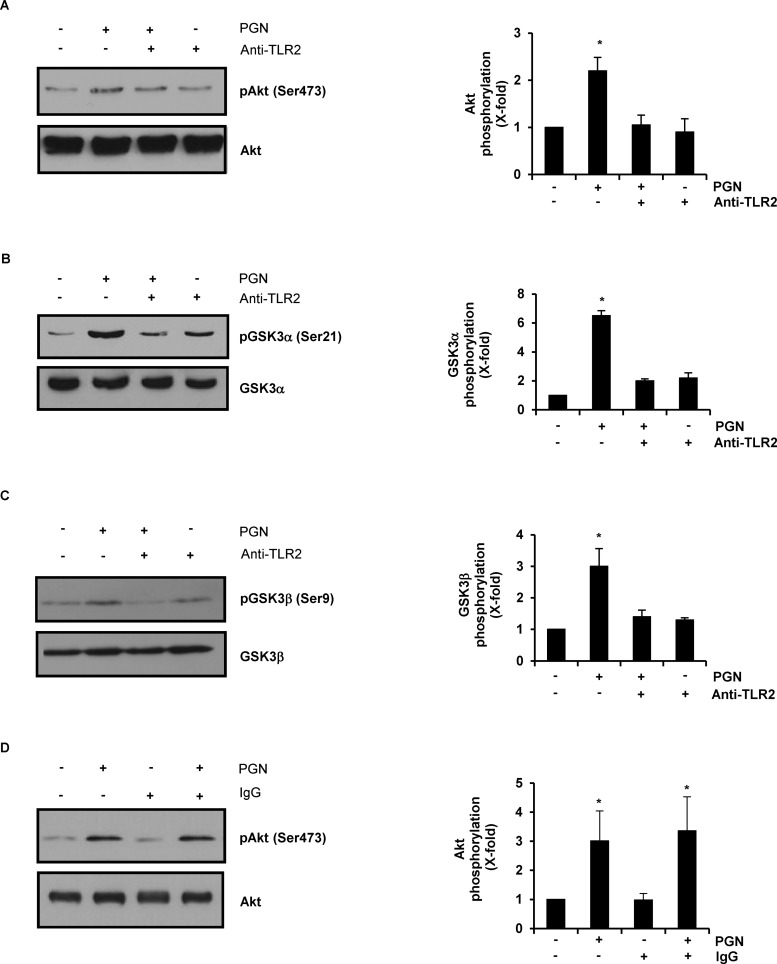
Peptidoglycan (PGN) induces phosphorylation of Akt, GSK3α and GSK3β in bovine endothelial cells (BEC) through TLR2 activation.A, B, C) BEC were either stimulated with 10 μg/mL of PGN for 30 min, pre-incubated with 5 μg/mL of neutralizing antibody against the extracellular domain of TLR2 (anti-TLR2) for 60 min and stimulated with 10 μg/mL of PGN for 30 min or pre-incubated with 5 μg/mL of anti-TLR2 for 60 min. D) BEC were either stimulated with 10 μg/mL of PGN for 30 min, pre-incubated with 5 μg/mL of an isotype anti-IgG for 60 min or pre-incubated with 5 μg/mL of anti-IgG for 60 min and stimulated with 10 μg/mL of PGN for 30 min. As control in all cases A-D, BEC were left untreated (-). After treatments, protein extracts were analyzed by western blot and probed with monoclonal antibodies against the phosphorylated forms of Akt1 (pAkt Ser473), GSK3α (pGSK3α Ser21) or GSK3β (pGSK3β Ser9). Blots were stripped and reprobed with an antibody that recognizes the nonphosphorylated forms of Akt (A, and D), GSK3α (B) or GSK3β (C) to verify equal protein loading. Blots are representative of three independent experiments. Graphs on the right panel indicate the band intensity obtained by densitometric analysis. Results are expressed as the mean ± S.E.M. (n = 3). *p < 0.05, compared with the untreated control.